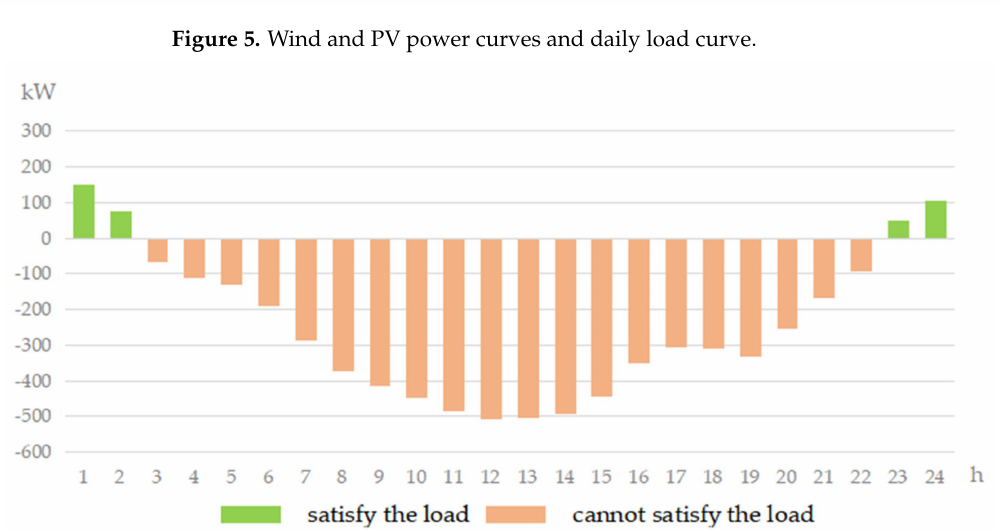
Figure 5. Wind and PV power curves and daily load curve.